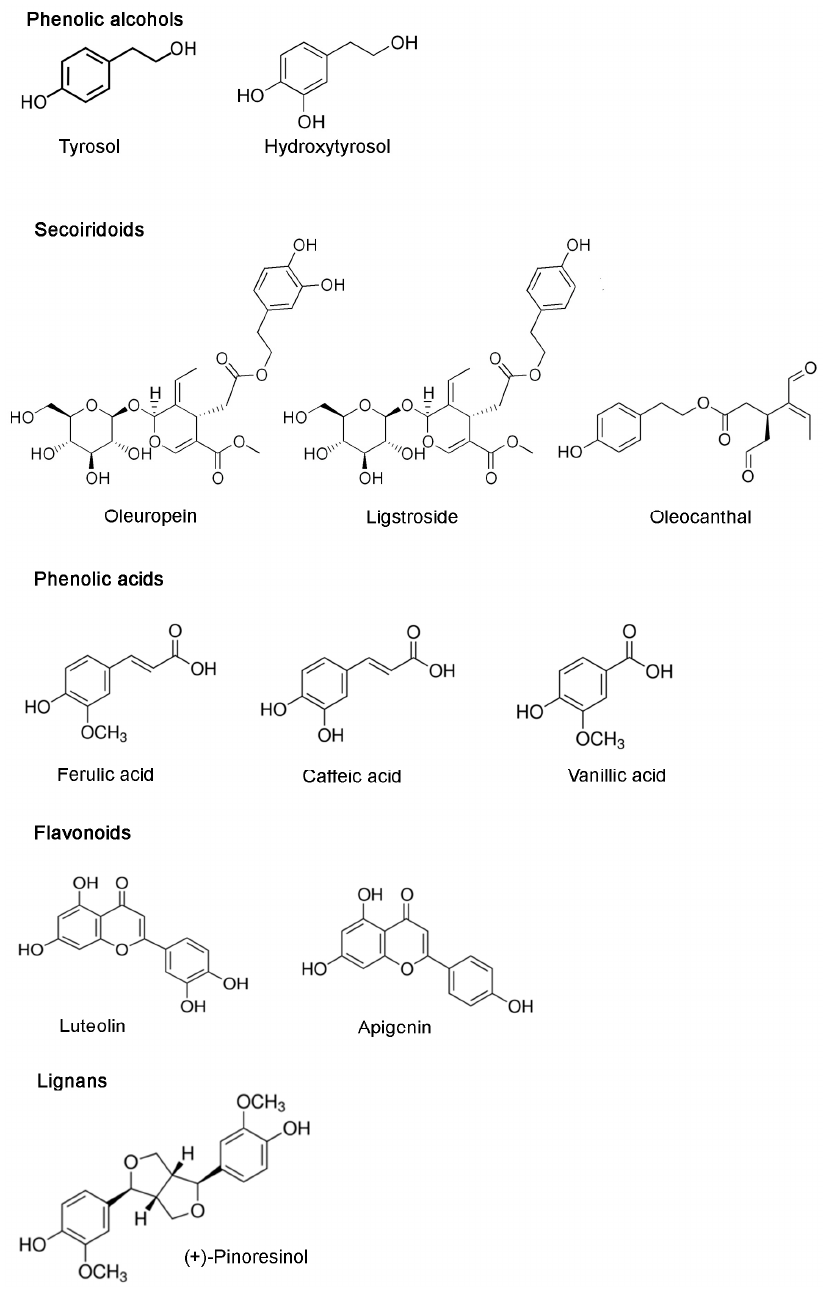
Figure 1. Main phenolic subclasses in olive oil and some representative compounds.